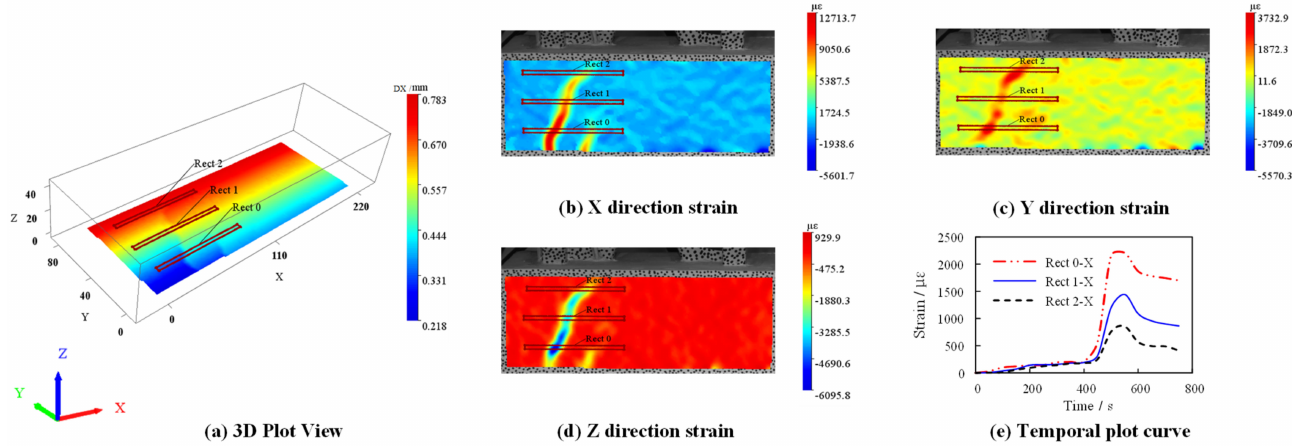
Figure 10. Scattering displacement and strain of MSSC-02 specimen.